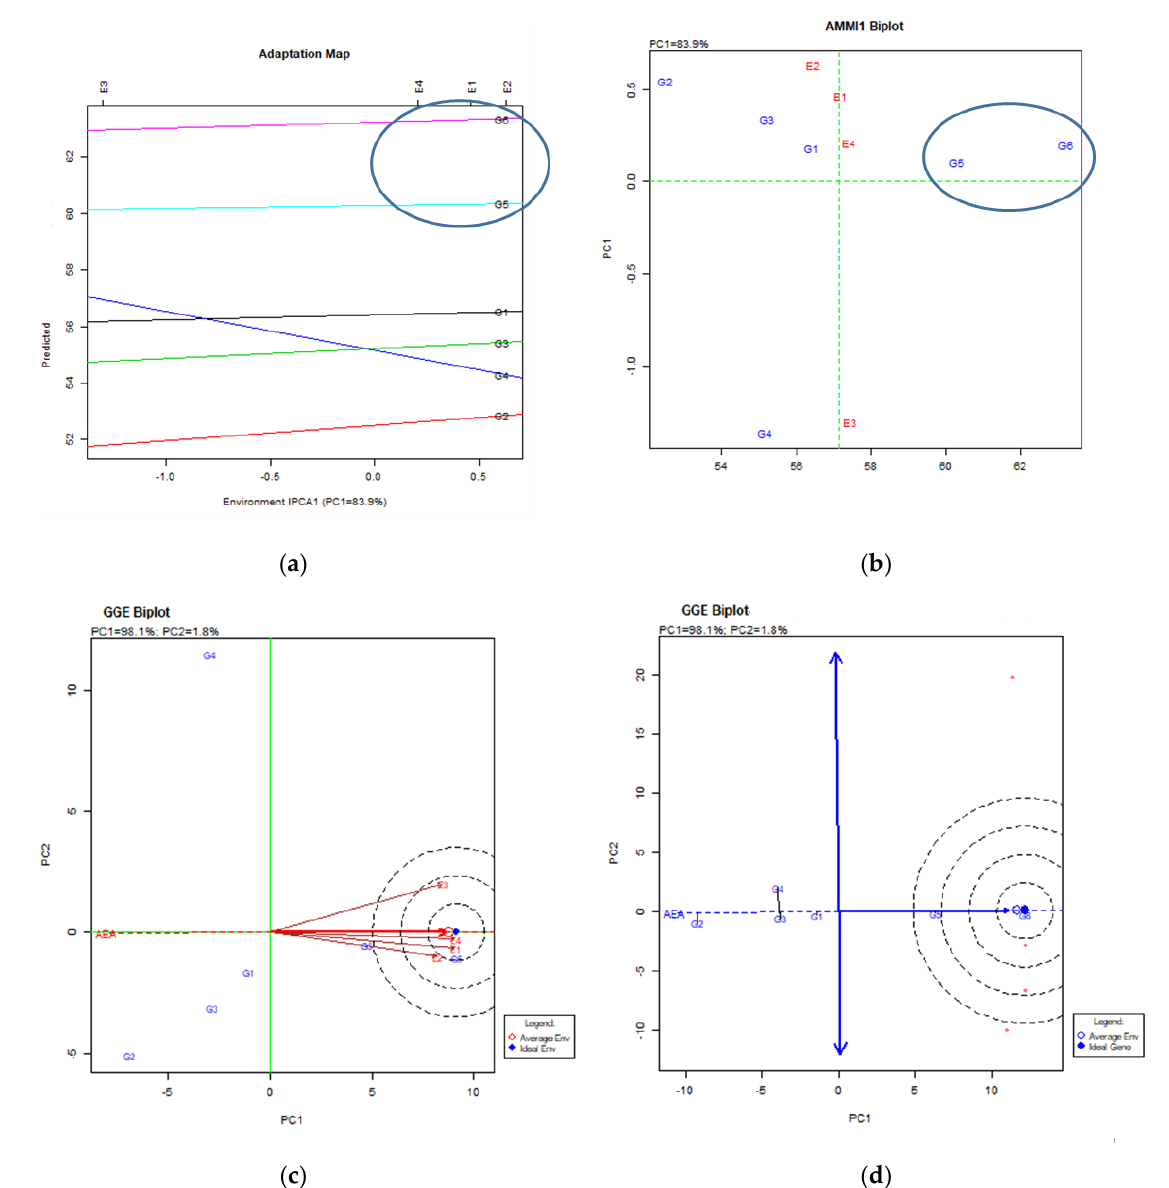
Figure 3. Stability analysis for thousand kernel weight (g) based on ( a ) the adaptation map where the X-axis (PC1) visualizes the stability of varieties over environments and the Y-axis — the performance of varieties for the trait; ( b ) the AMMI1 biplot where the Y-axis is the one visualizing the trait performance and the X-axis (PC1) visualizes the stability of varieties over environments; ( c ) the GGE biplot for environments depicting the stability of the environments over years via the placement as near as possible to the ideal and average environment; ( d ) the GGE biplot for varieties depicting the stability of the varieties over environments where the productive varieties are those to the right on the AEA vector and the stable ones are those which are as close to the AEA axis as possible.